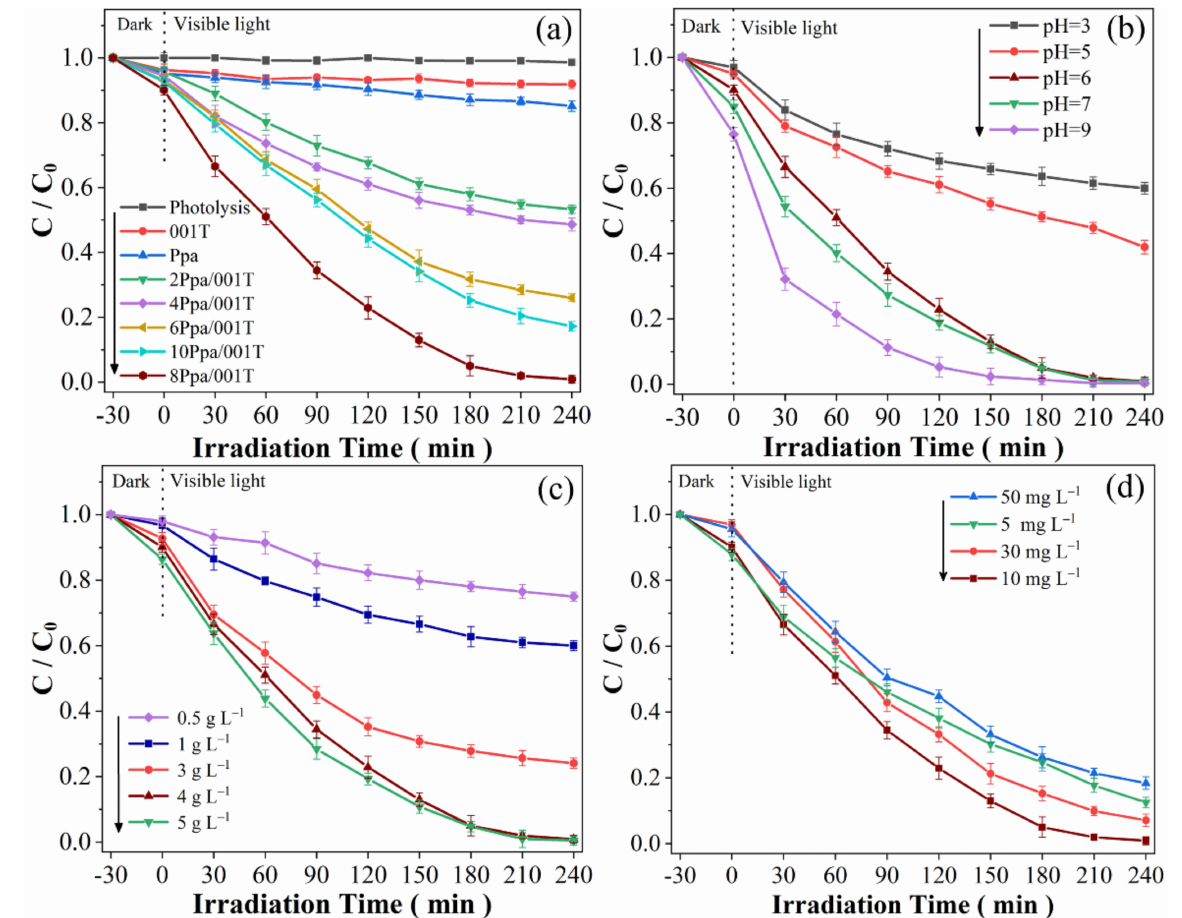
Figure 5. ( a ) Photocatalytic degradation of AME over the 001T, Ppa, and xPpa/001T samples under visible-light irradiation for 4 h; ( b ) Effect of the pH on the degradation of 10 mg L − 1 AME pollutant over the 8Ppa/001T catalyst (4 g L − 1 ); ( c ) Effect of the change in content of the 8Ppa/001T catalyst on the degradation of 10 mg L − 1 AME at pH 6; ( d ) Effect of the solution concentration on the degradation rate of AME over the 8Ppa/001T catalyst at pH 6 (catalyst content = 4 g L − 1